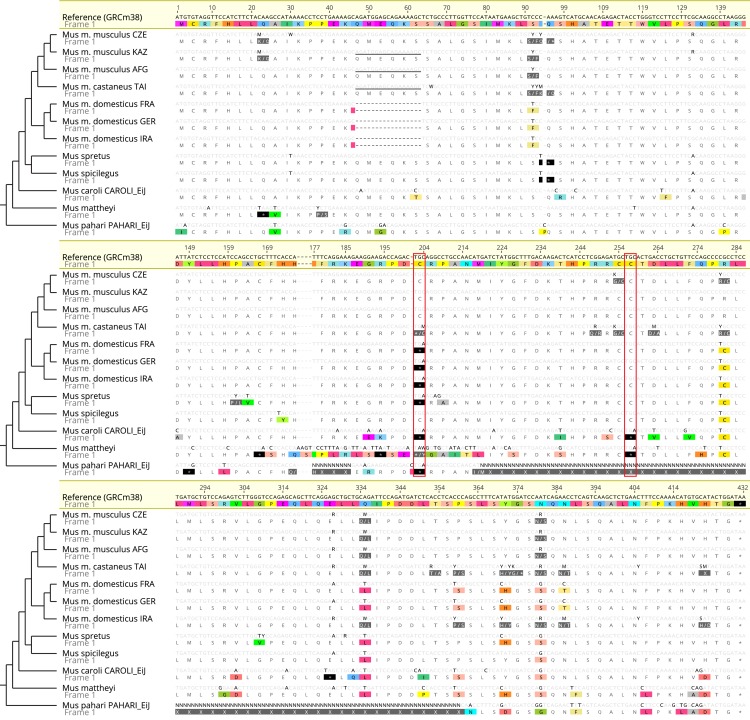
Alignment of the ORF of Gm13030 among the mouse populations, subspecies and related species where the sequence could be identified in the respective genomic region.All nucleotide sequences are aligned to the mm10 mouse reference, and amino acids are translated according to the reference frame (note that this implies that the frameshifts in the individual sequences are not shown). Alignment was done in Geneious Prime (2019.0.3 Biomatters Ltd.). The topology of the species tree is shown to the left. ‘Mus m.’ represents Mus musculus. Mus musculus populations are marked with 3-letter origin designations, and sequences from inbred strains are marked with strain designations. Nucleotides and amino acids are shown in IUPAC codes. The two rectangles mark the positions of the enabler mutations.